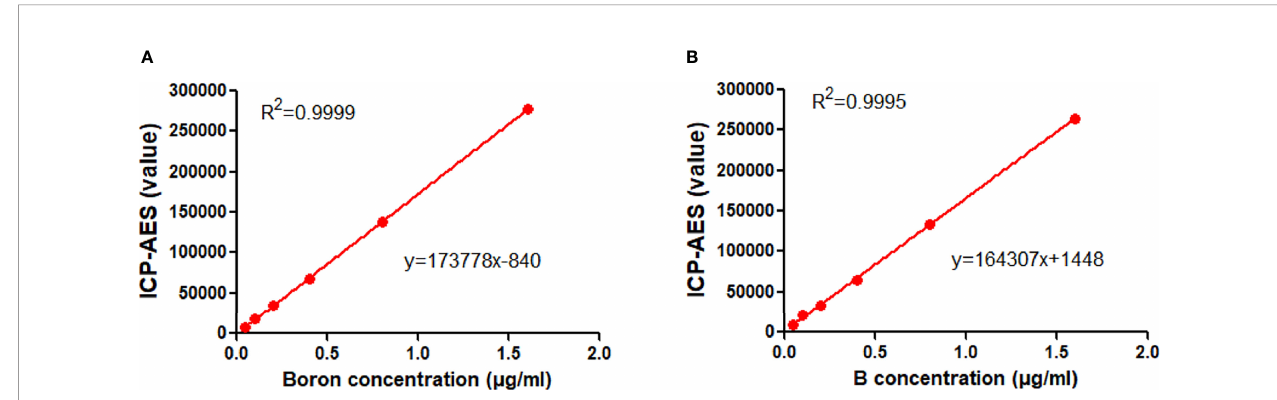
FIGURE 2 | Standard curve of BPA. (A) The linear correlation between the ICP-AES value and boron concentrations in the fi rst set of experiment in which BPA was added in PBS. (B) The linear correlation between the ICP-AES value and boron concentrations in the second set of experiment in which BPA was added in rat